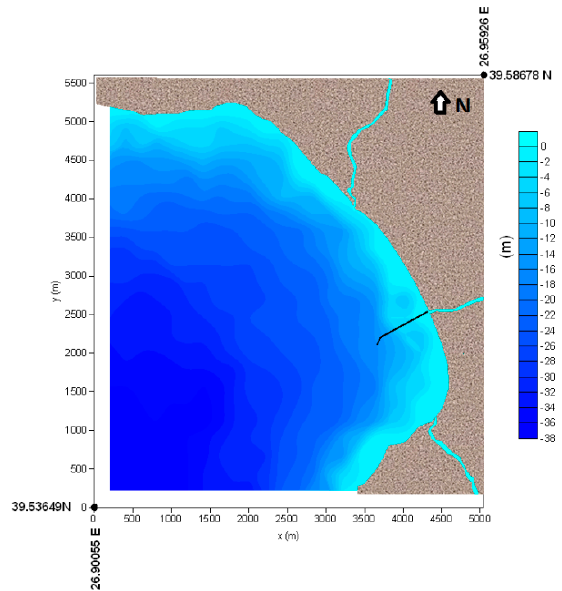
Figure 6. Water depth (m) and the location of outfall pipe.